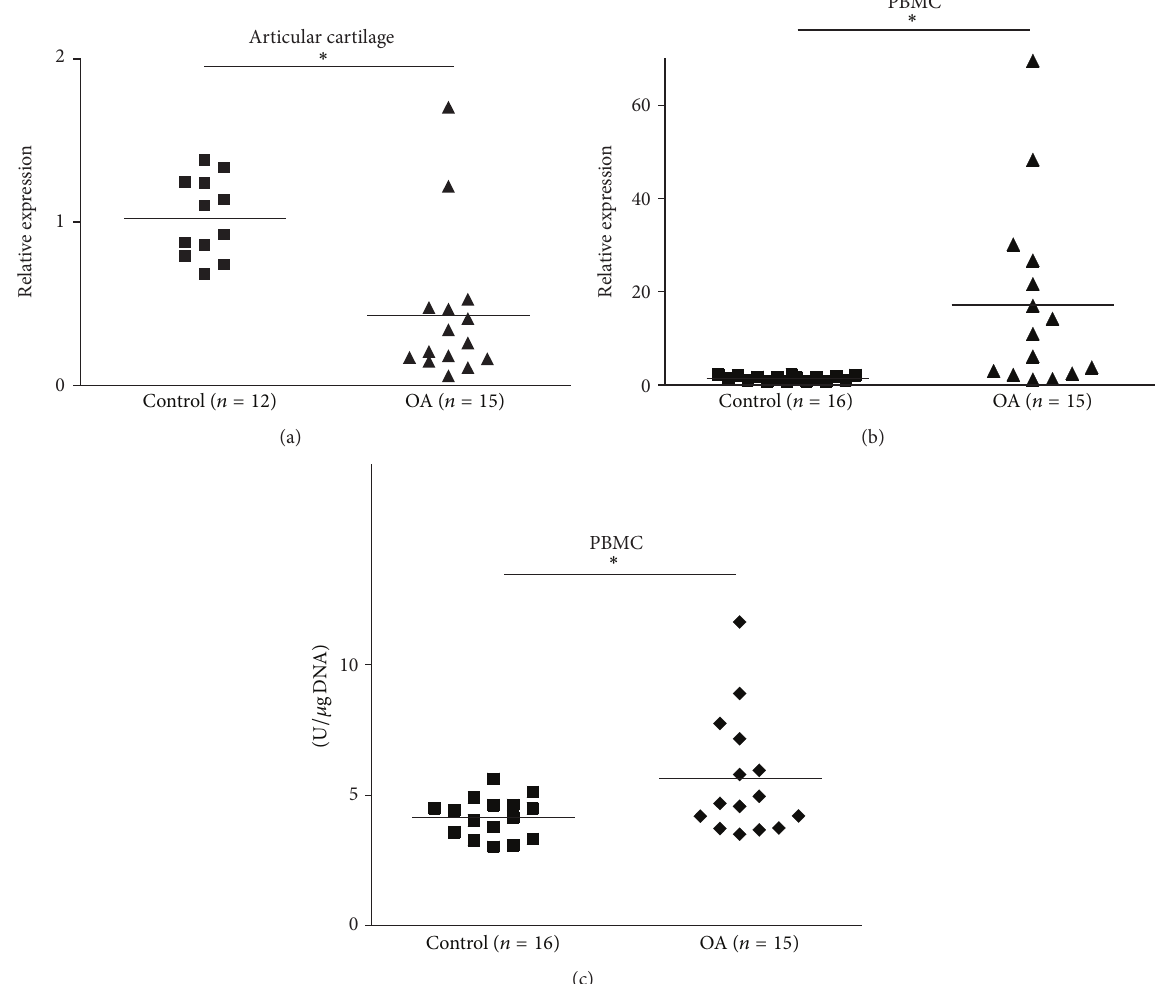
Figure 5: AMPK expression. Relative gene expression in (a) articular cartilages of healthy ( 𝑛 = 12 ) and OA patients ( 𝑛 = 15 ) and in (b) PBMCs of the same OA patients ( 𝑛 = 15 ) versus 16 healthy subjects, as determined by real-time PCR analyses with reference to 𝛽 -actin. (c) pAMPK protein concentrations in PBMCs of the same OA patients ( 𝑛 = 15 ) versus 16 healthy subjects as determined by ELISA. Asterisks ( ∗ ) indicate significant differences from controls (Mann–Whitney U